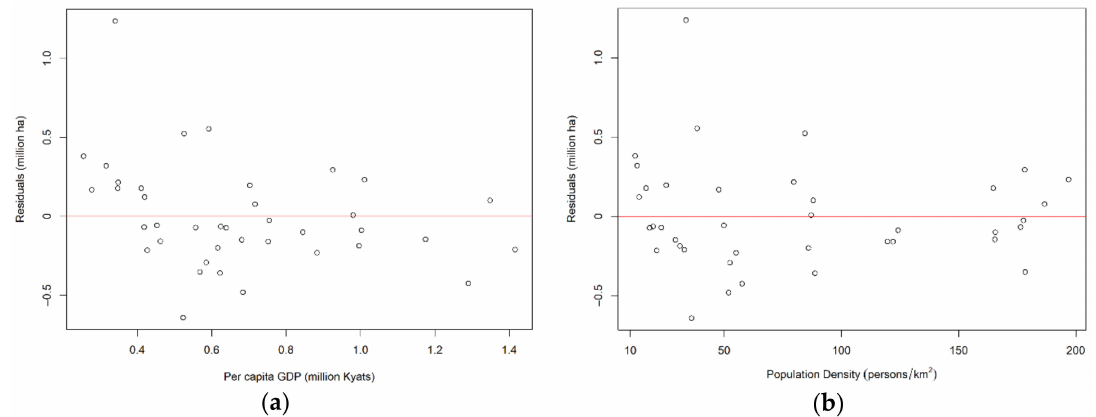
Figure 4. Visual model validation: ( a ) residuals versus PGDP; ( b ) residuals versus